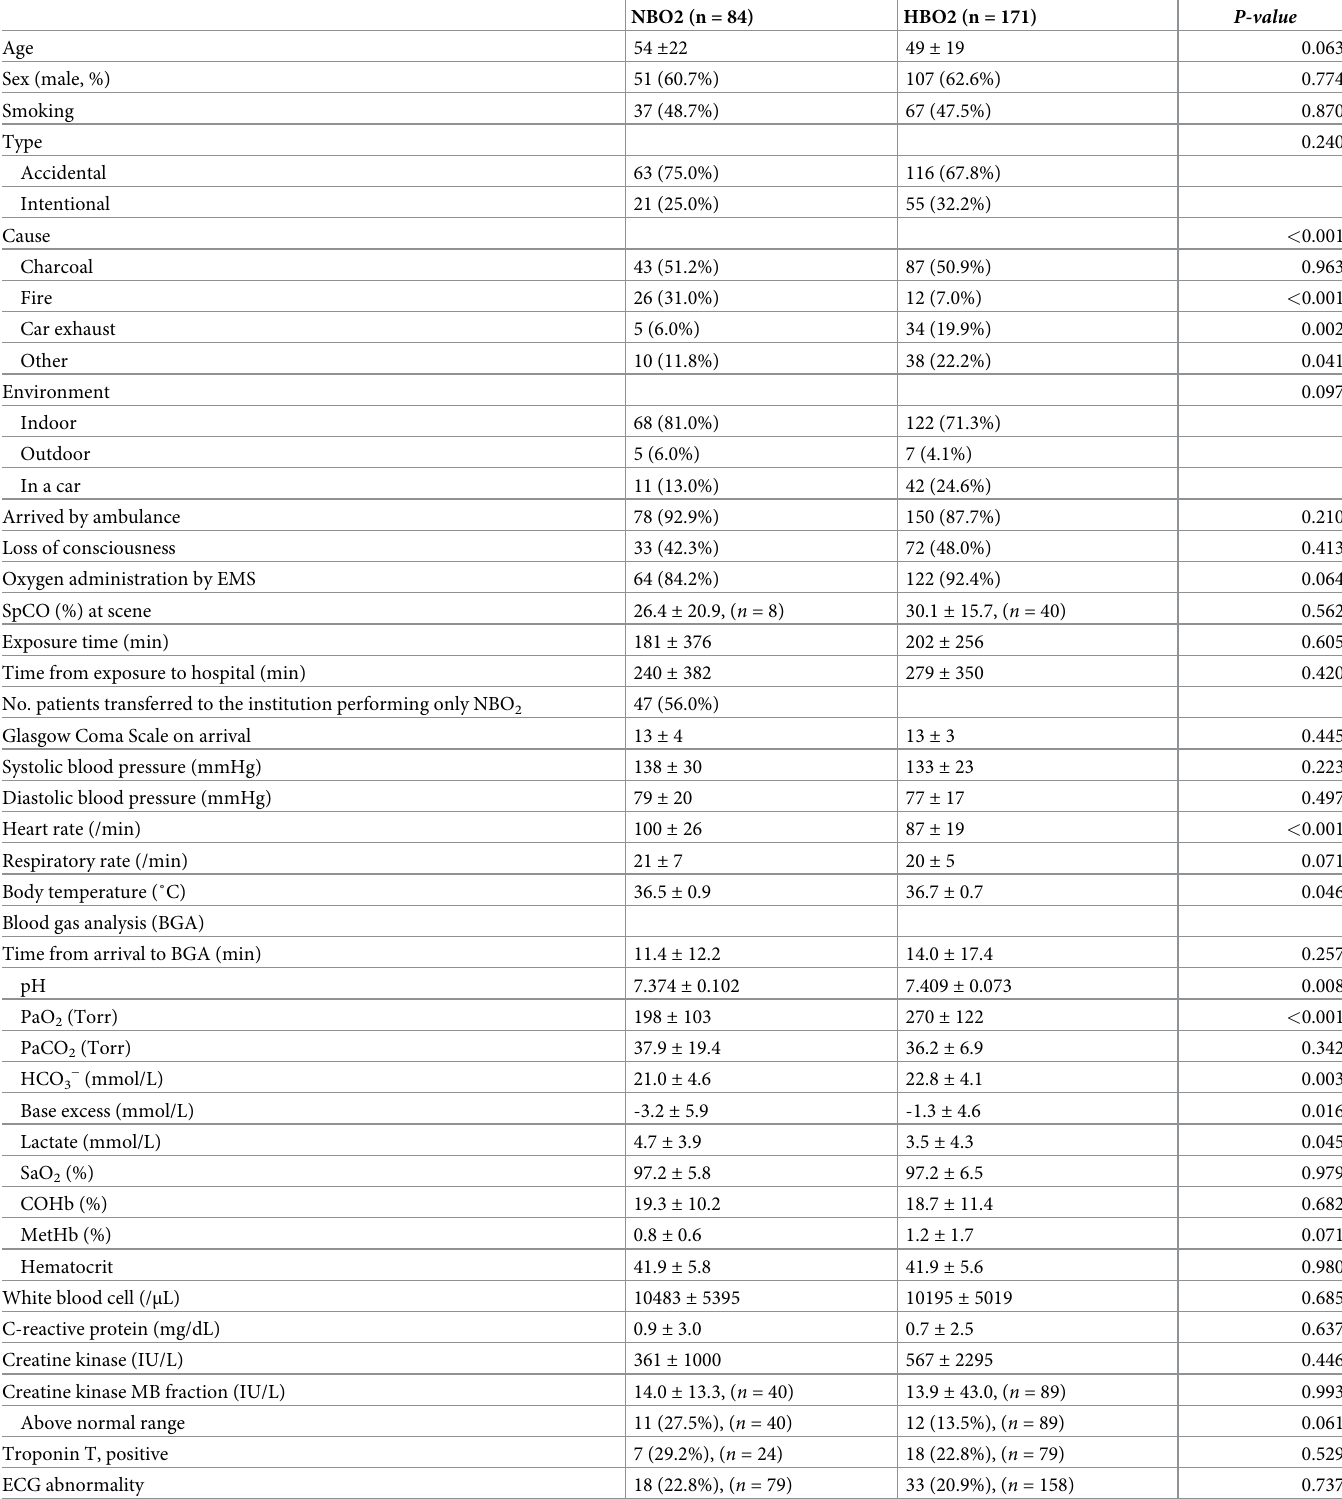
Table 1. Patient characteristics and physiological and laboratory findings upon